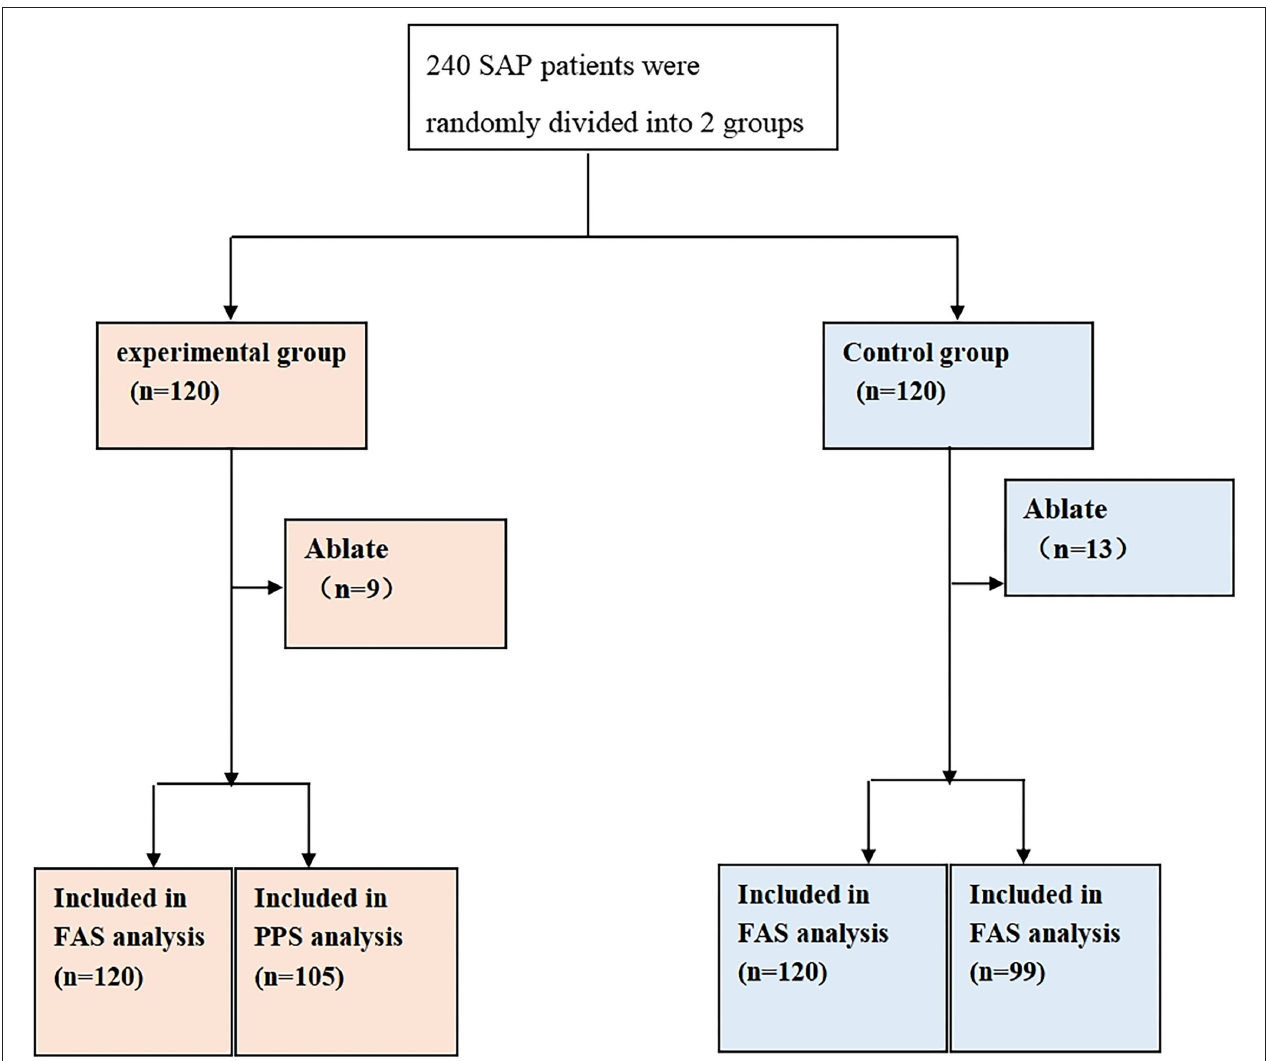
FIGURE 1 | Randomization grouping. A total of 240 patients who met the criteria were recruited and randomly arranged into 2 groups, including 120 patients in the experimental group and 120 in the control group. As for the experimental group, 9 cases were dropout, with 120 patients in the FAS analysis and 105 in the PPS analysis. For the control group, 13 cases were dropout, with 120 patients in the FAS analysis and 99 in the PPS analysis.